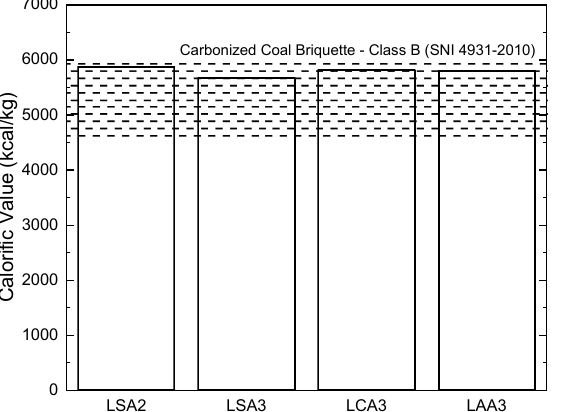
Figure 11. Calorific Value of the Resultant Lignin Briquettes.